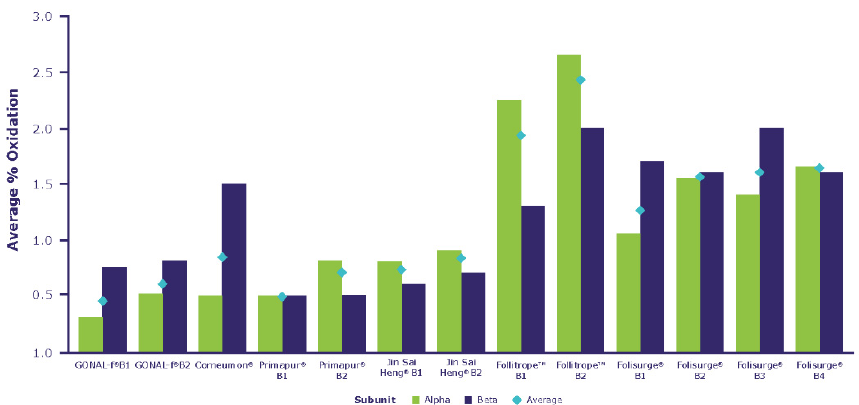
Figure 4. Comparative analysis of oxidation levels in the preparations.